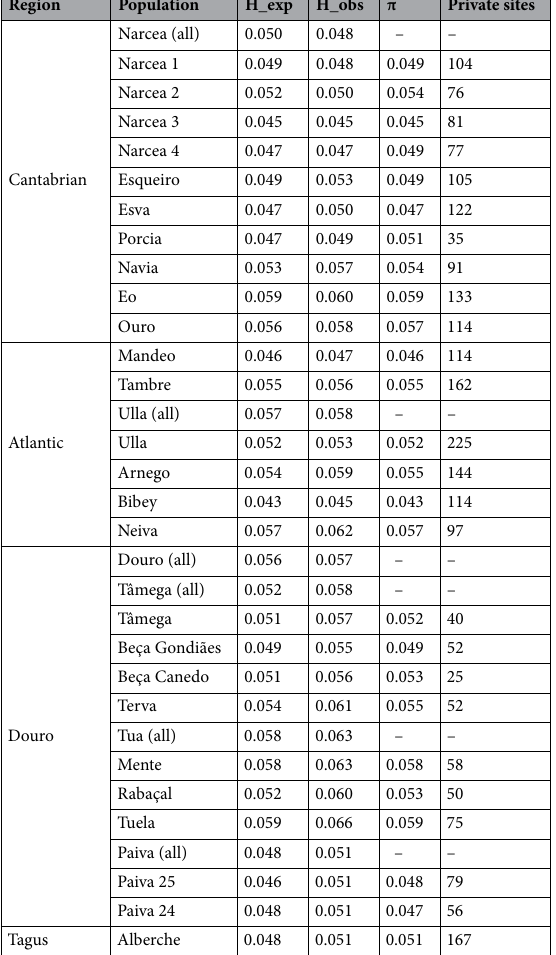
Table 1. Genetic diversity statistics: expected (H_exp) and observed (H_obs) heterozygosity, nucleotide diversity (π) and private sites for the dataset of 26 locations and 16 hydrological